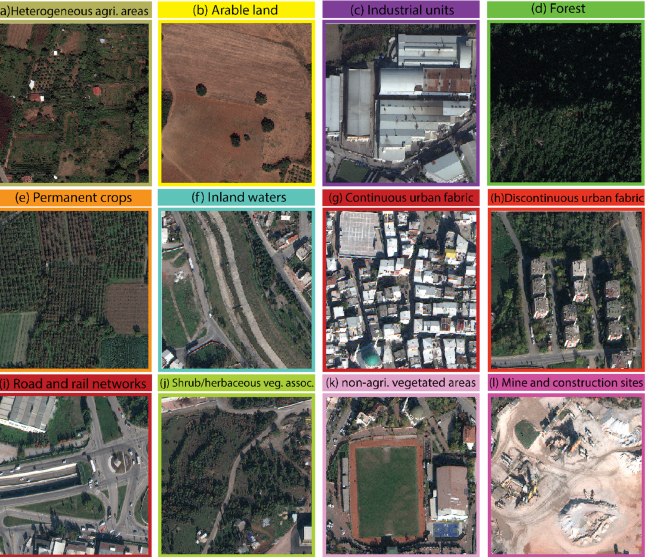
Figure 2. Sample patches from the WV-3 images of the study areas, representing different LULC classes adapted from CORINE second-level nomenclature. ( a ) Heterogeneous agricultural areas, ( b ) Arable land, ( c ) Industrial units, ( d ) Forest, ( e ) Permanent crops, ( f ) Inland waters, ( g ) Continuous urban fabric, ( h ) Discontinuous urban fabric, ( i ) Road and rail networks and associated land, ( j ) Shrub and/or herbaceous vegetation associations, ( k ) Artificial, non-agricultural vegetated areas, ( l ) Mine, dump, and construction